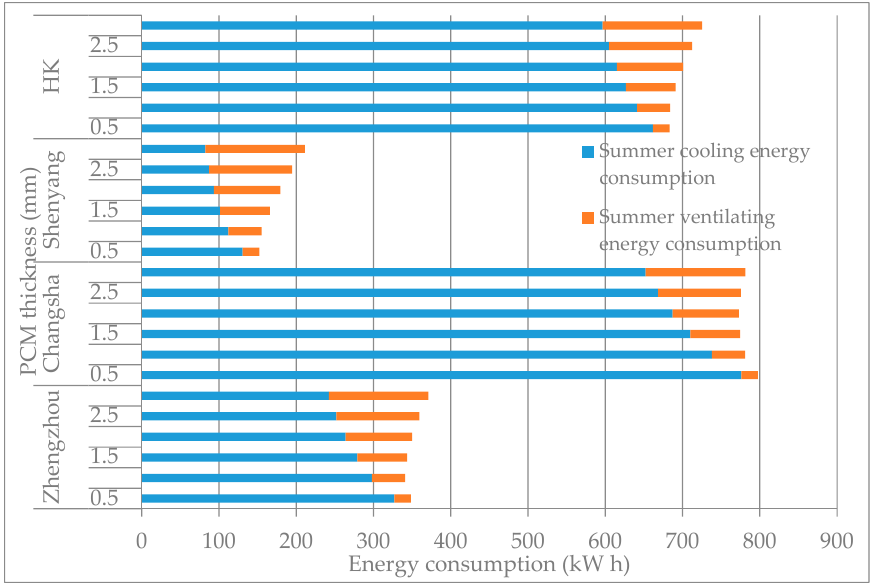
Figure 8. Summer energy consumption in different ventilation quantity.